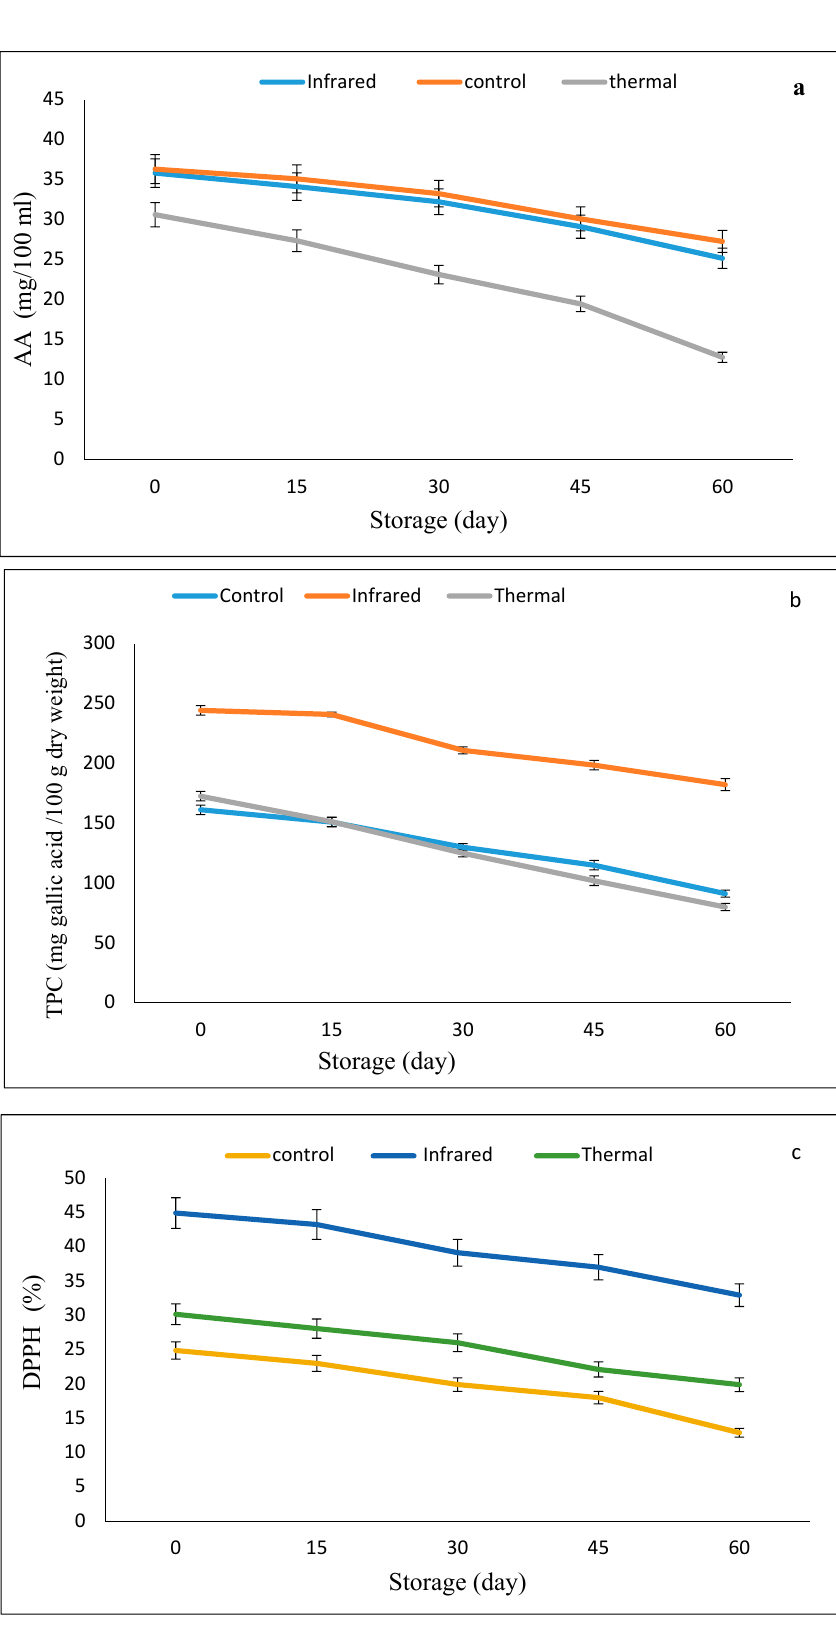
Figure 3. The ( a ) ascorbic acid ( b ) total phenolic content (TPC), and ( c ) antioxidant activity (DPPH % inhibition) of the infrared treated juice samples, the thermally treated samples (conventional), and the control sample during storage for 60 days at a temperature of 5 °C.